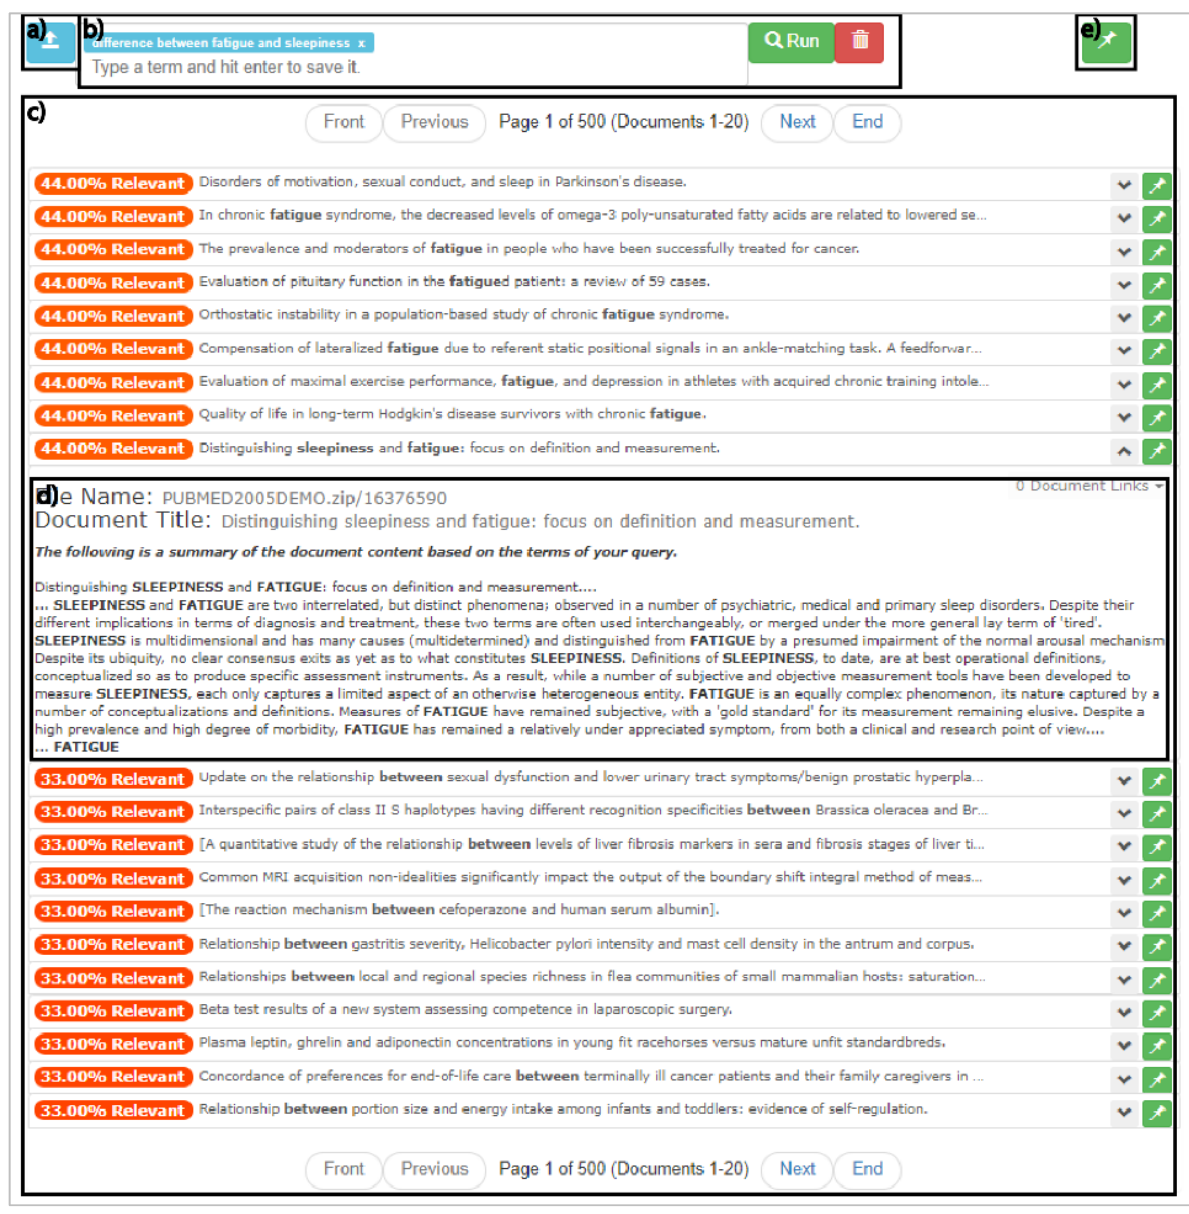
Figure 5. The overall view of ONTSI in full use and outlined coverage of its five subviews: Upload subview, partial ( a ); Search subview ( b ); Result List subview ( c ); Result Item subview ( d ); and Saved List subview, partial ( e ).